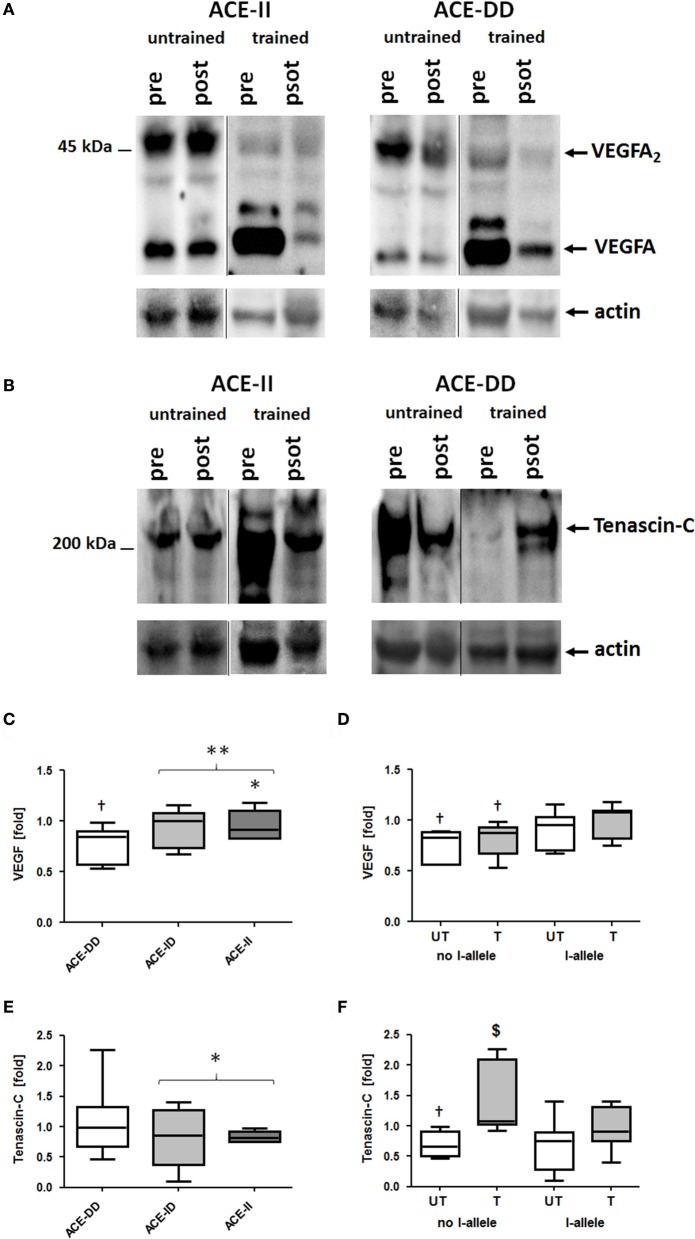
Effect of ACE-I/D genotype and training status on pro-angiogenic protein levels in vastus lateralis muscle. Examples of the detection of tenascin-C and VEGFA expression in vastus lateralis muscle pre- and post-exercise in homogenates of untrained and trained ACE-DD and ACE-II genotypes (A,B). Actin loading controls are shown below. C–F) Box-and-whisker plot of median fold changes in VEGFA (C,D) and Tenascin-C (E,F) 30-min post exercise vs. pre- for the 52 studied subjects when split for ACE-I/D genotype (C,E; 26xACE-DD, 20xACE-ID, 6xACE-II) or training state and the presence of the ACE I-allele (D, F; untrained: untrained: 11xACE-DD, 10xACE-ID, 3xACE-II; trained: 15xACE-DD, 10xACE-ID, 3xACE-II). The lines denote the median, the box delimits the quartiles and the whiskers denote the farthest points that are not outliers. †p < 0.05 vs. pre; $p < 0.05 vs. same genotype untrained; * and ** denote p < 0.05 and p < 0.01 vs. ACE-DD (no I-allele), respectively. Univariate ANOVA with post hoc test of Fisher. Only genotype effects are indicated.